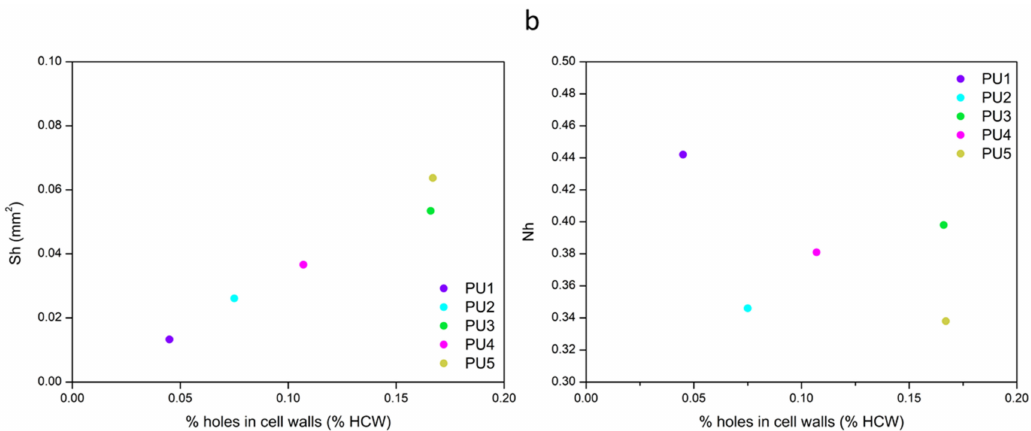
Figure 8. Relationship between the average surface of holes ( a ) and the number of holes ( b ) with the percentage of holes in the cell